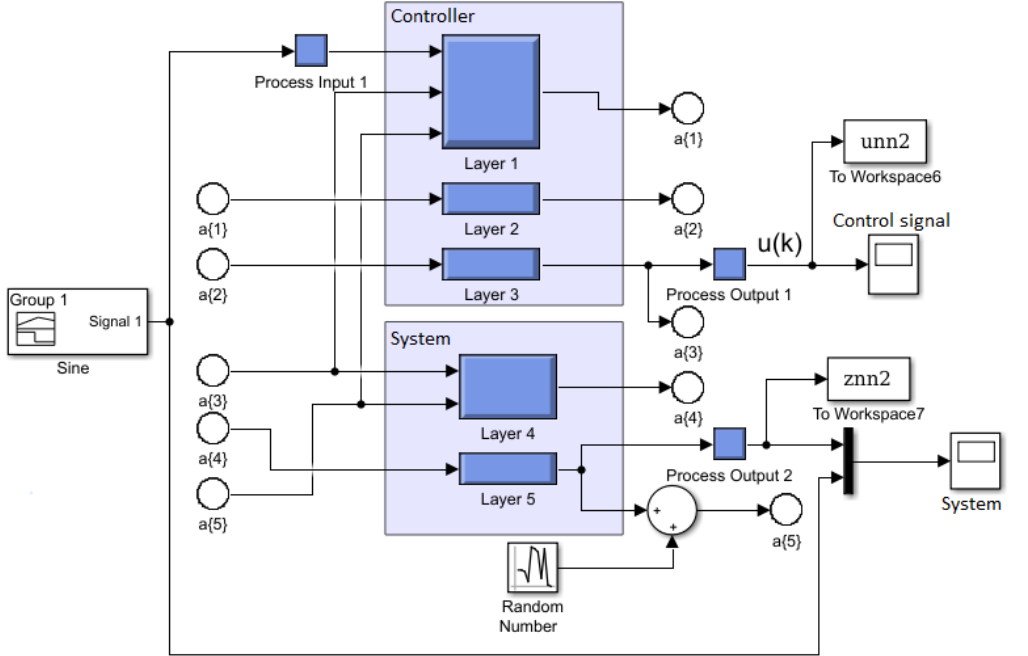
Figure 28. Simulink diagram of the model reference